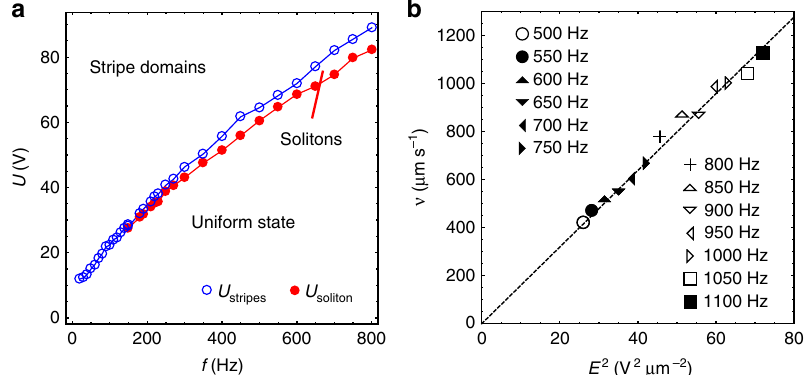
Fig. 6 Soliton properties as a function of the applied fi eld. a Frequency dependencies of U soliton and U stripes (8.0 μ m, 45 °C). b Velocity of solitons vs. square of the electric fi eld (7.8 μ m, 50 °C); the applied fi eld corresponds to the frequencies speci fi ed in the